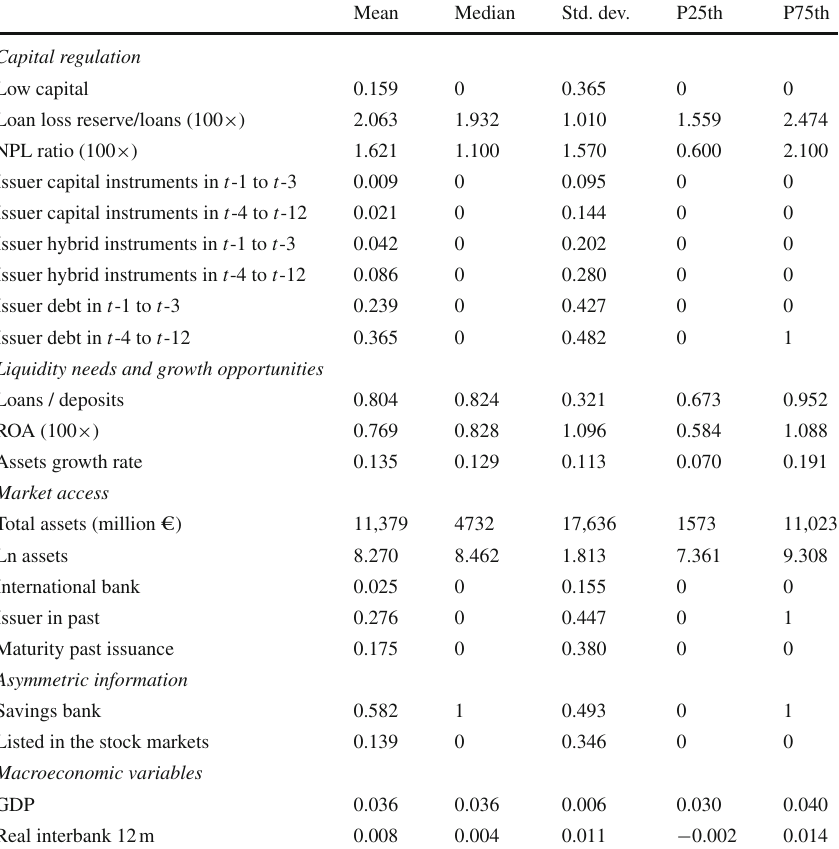
Table 2 Descriptive statistics of explanatory variables. Spanish banks,